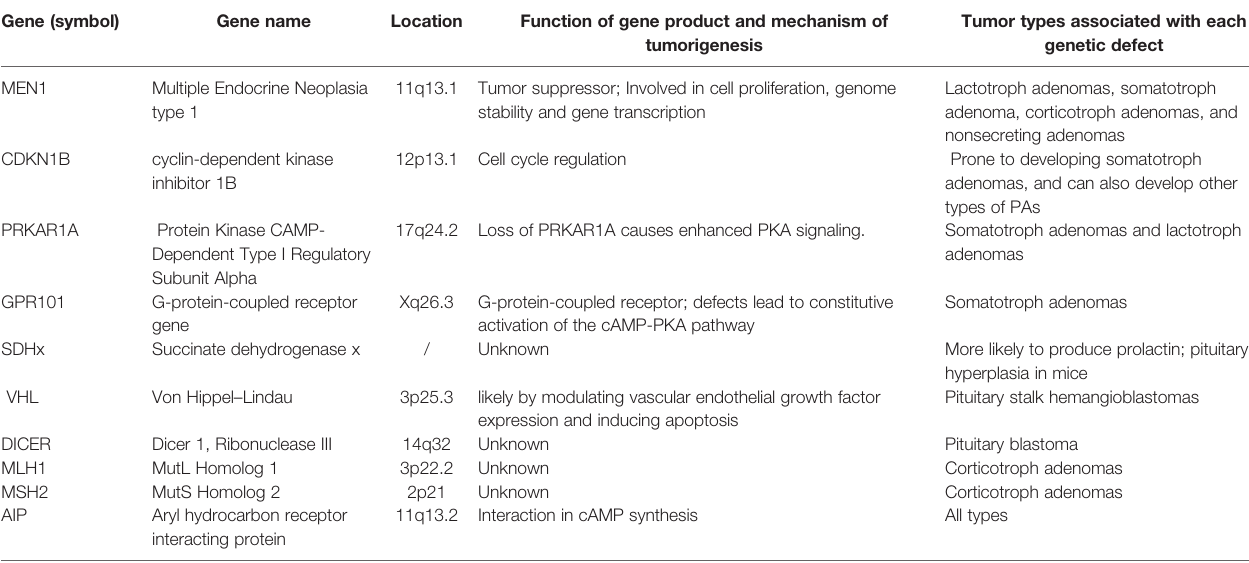
TABLE 1 | Genes affected in different pituitary tumors via genetic mutation or DNA methylation. Gene